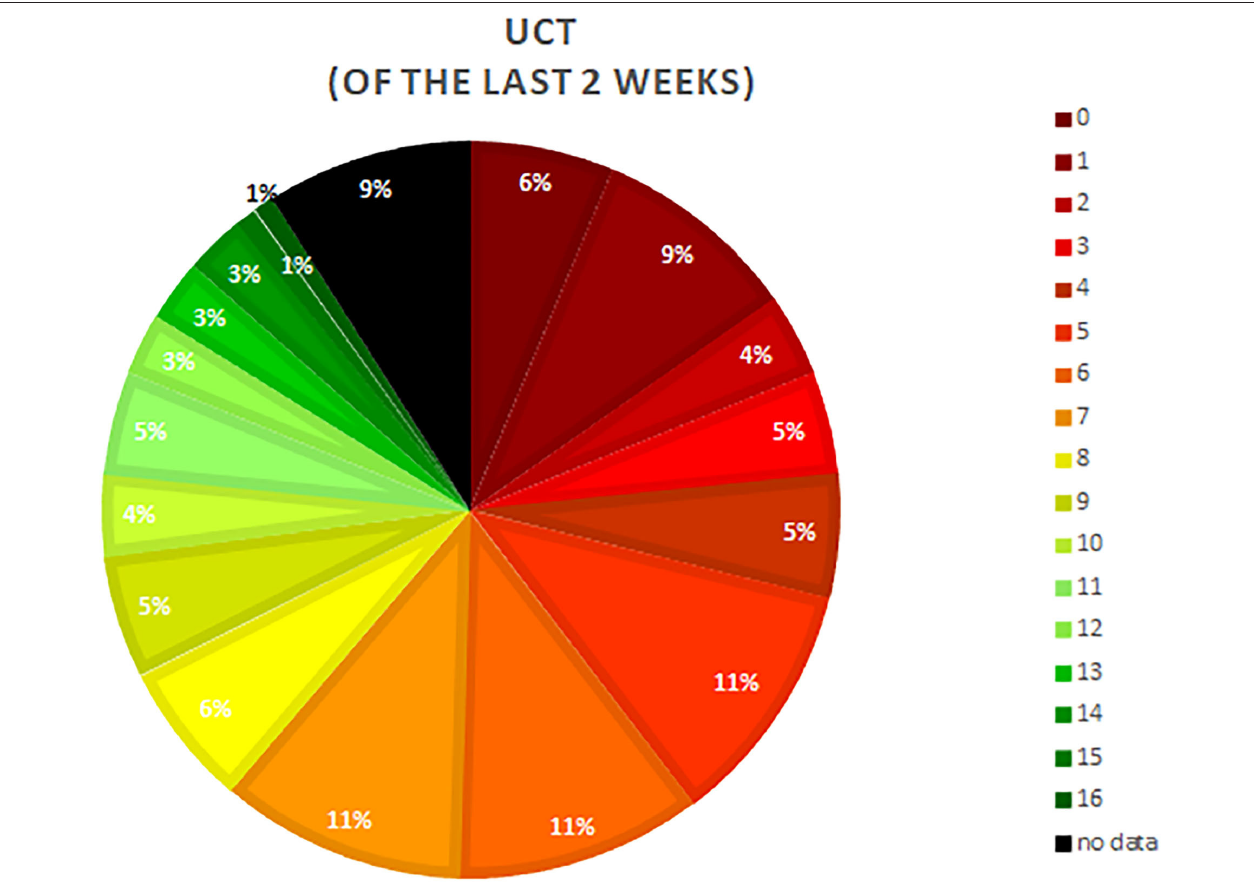
FIGURE 2 | Depiction of the distribution of the Urticaria Control Test (UCT) point results. UCT scores of more than 12 points indicate sufficient disease control. The lower the achieved points the less controlled the disease was at the time point of